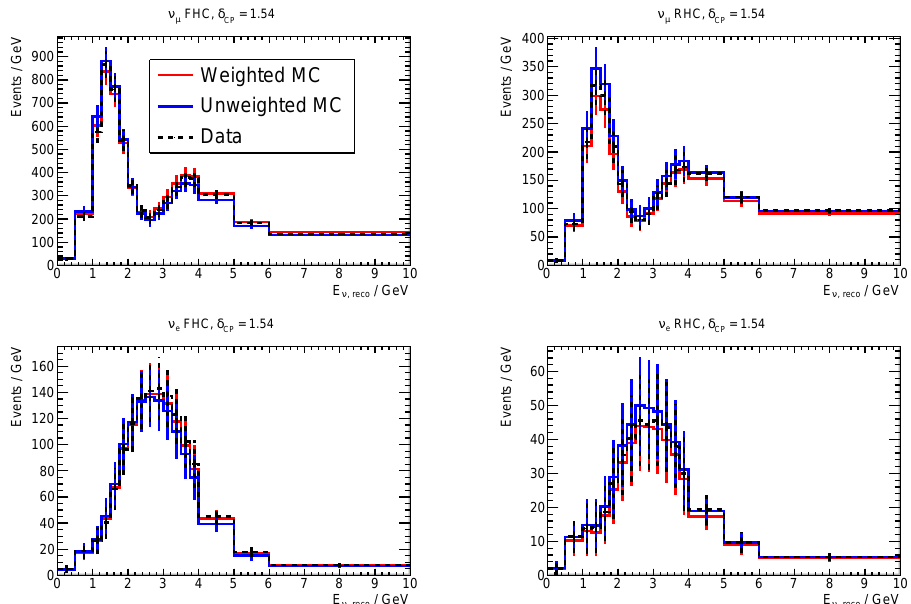
Figure 71. Comparison of simulated far detector spectra with and without the ND-derived weighting. The black line shows the spectra for the NuWro reweighted mock data. The blue line shows the nominal MC. The red line shows the nominal MC with the near detector-derived weighting. Errors correspond to 1 years POT.